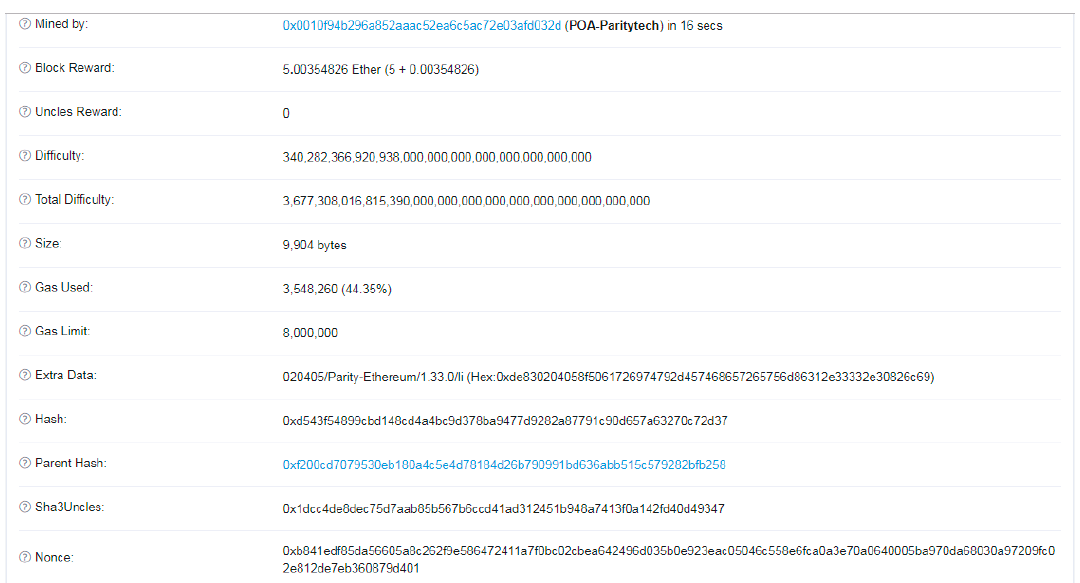
Figure 9. Blockchain smart contract transactions on Ethereum.